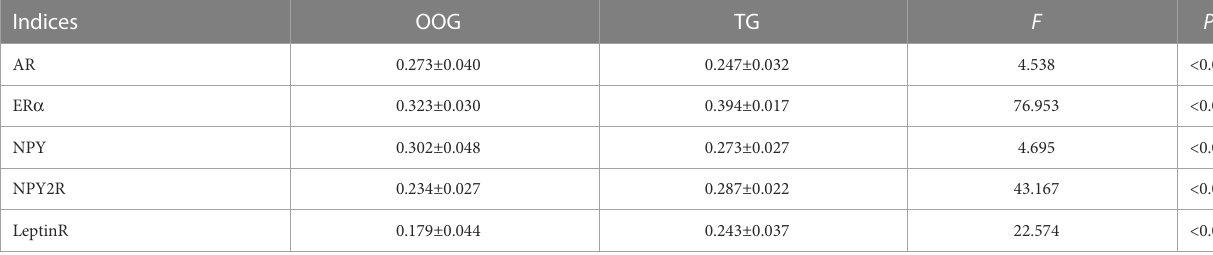
TABLE 6 Comparisons of proteins levels between OOG and TG in the hypothalamus of male offspring ( (cid:1) x ± s ). Indices